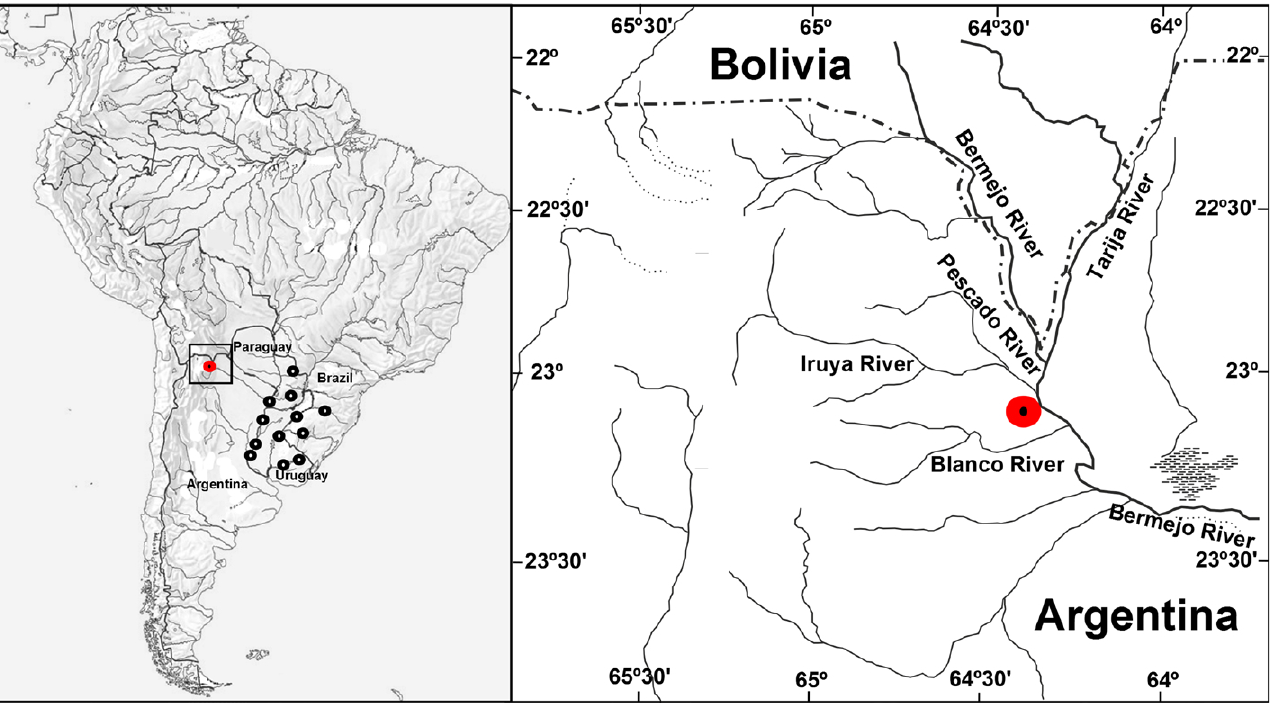
Figure 1. Distribution range of Bunocephalus doriae . Black dots represent the localities known so far (Ferraris 2007; Cardozo 2010; Serra et al. 2014; Almirón et al. 2015) and the red dot indicates the new record for the species herein